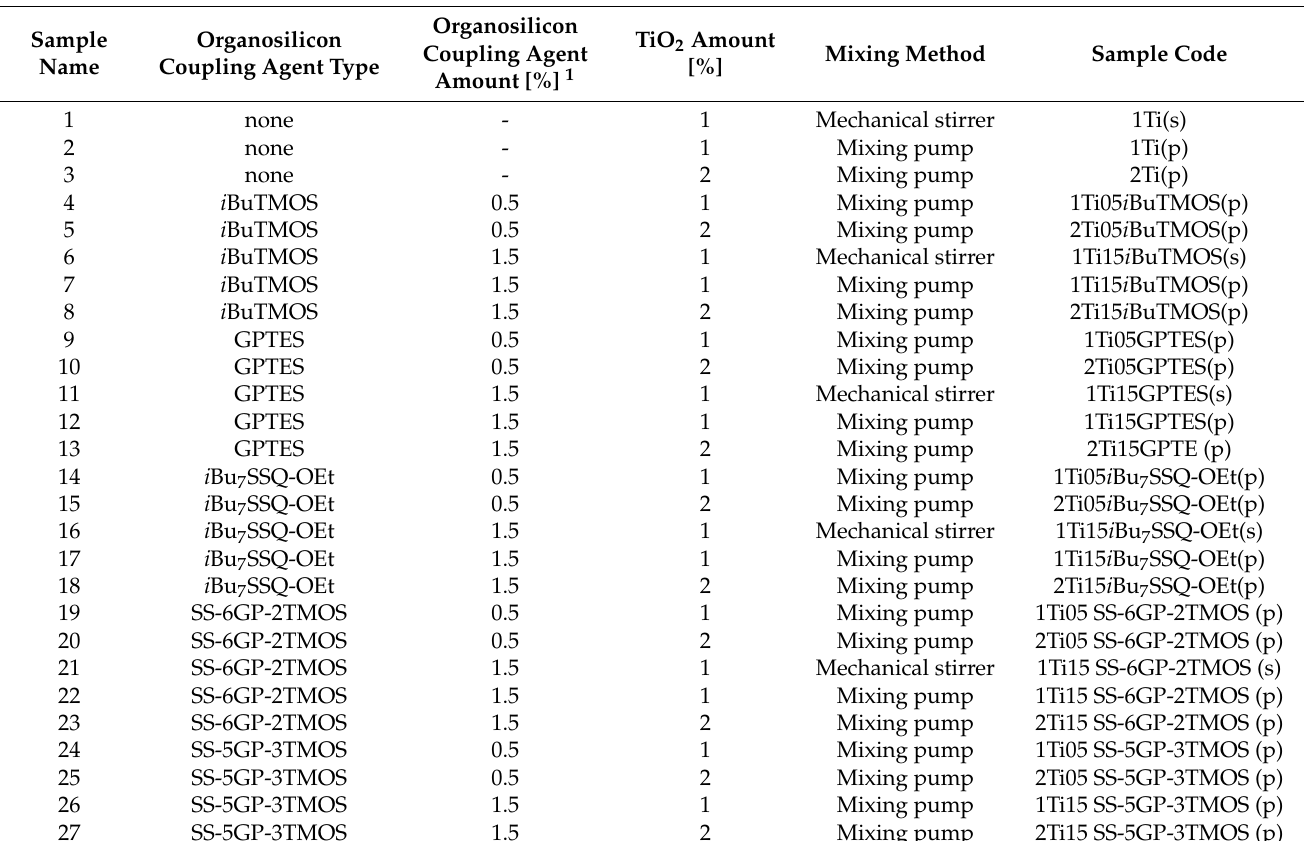
Table 2. The TiO 2 /epoxy resin composites prepared in this